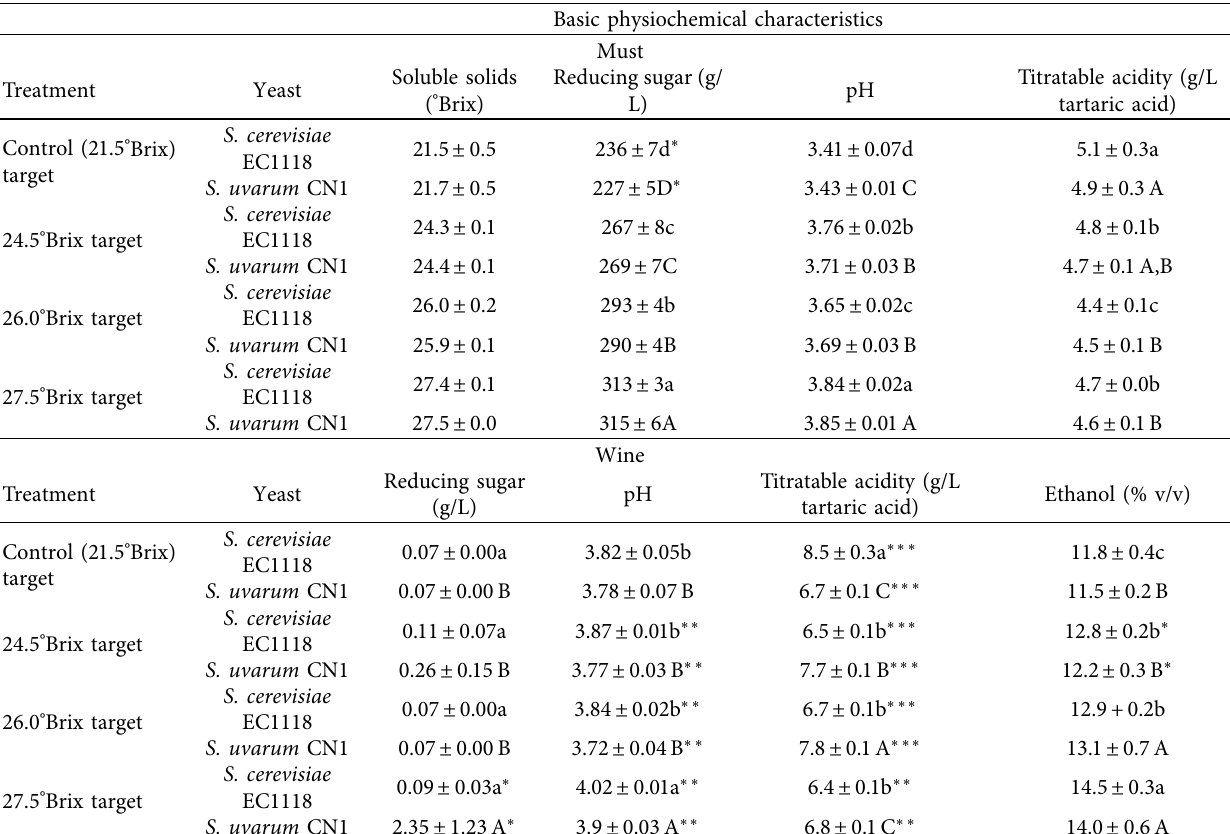
Table 2: Metabolites and basic physiochemical characteristics in must and wine samples (mean ± standard deviation) at each starting sugar